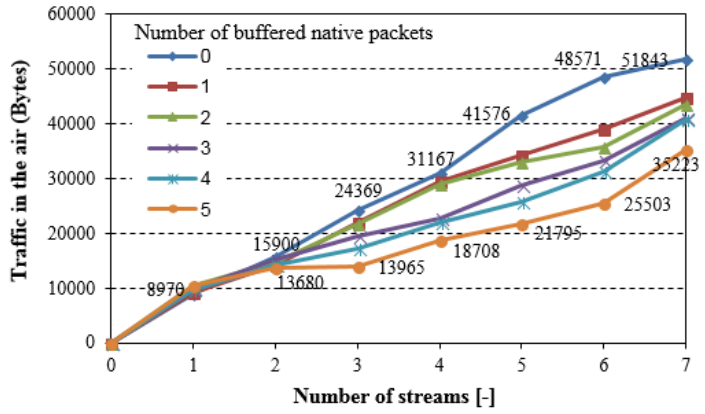
Figure 11. Overall traffic captured in the air (extended testing scenario).